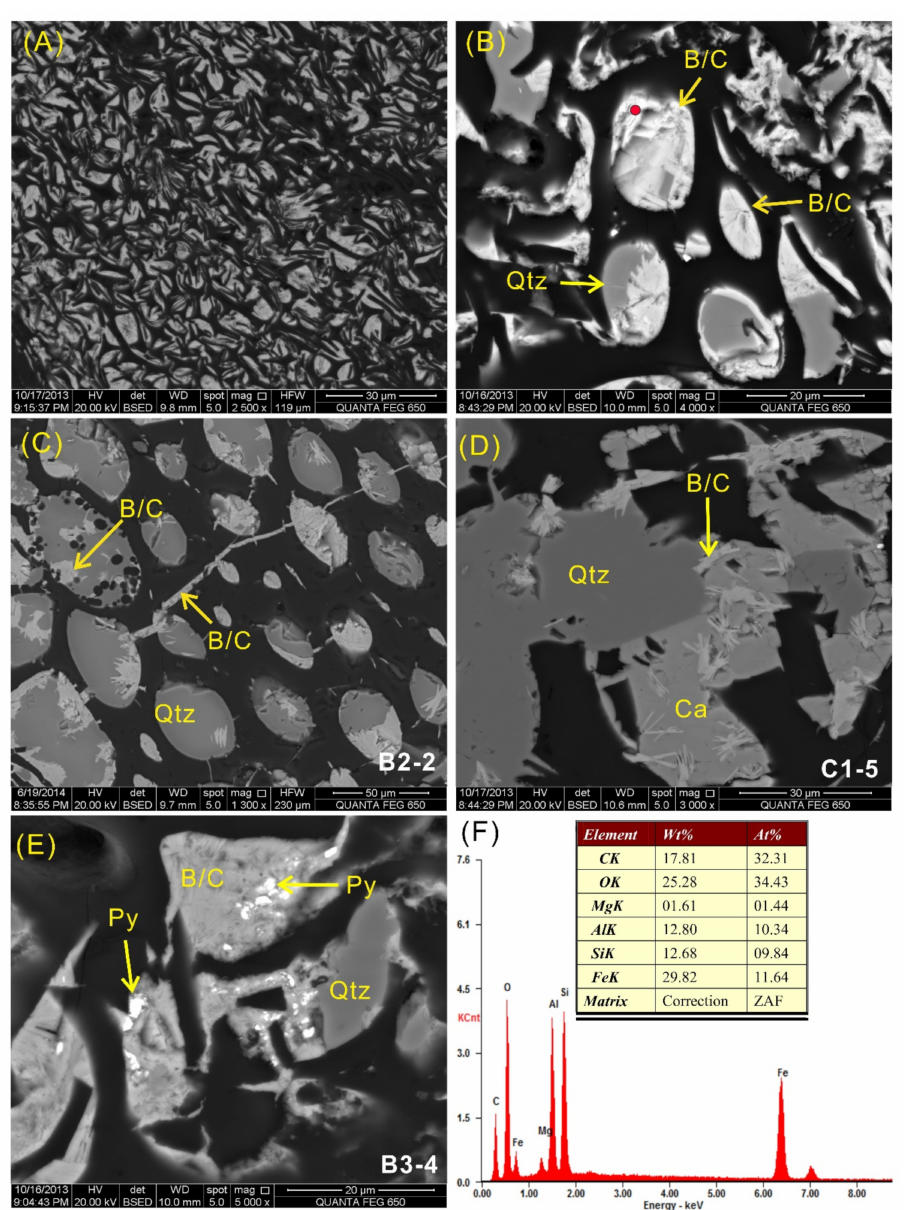
Figure 5. SEM back-scattered electron images of cell-filling minerals in coal samples and EDS data of a selected point. ( A ) Interstratified berthierine/chamosite as cell-infillings in sample C1-5. ( B ) Quartz coated with interstratified berthierine/chamosite as cell-infillings in sample B3-4. ( C – E ) Cell-filing interstratified berthierine/chamosite, quartz, calcite, and pyrite in samples B2-2 ( C ), sample C1-5 ( D ), and B3-4 ( E ). ( F ) EDS spectrum of point 1 in ( B ). Qtz: quartz. B/C: interstratified berthierine/chamosite. Py: pyrite. Ca: